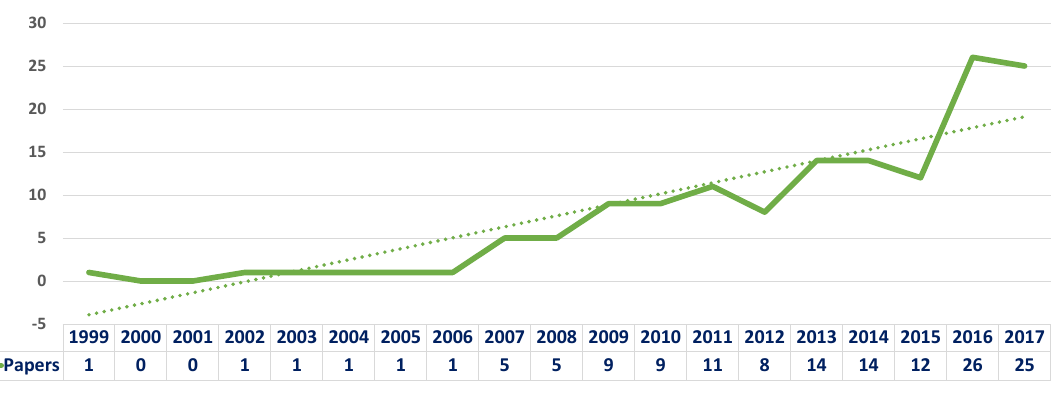
Figure 7. Annual trend of